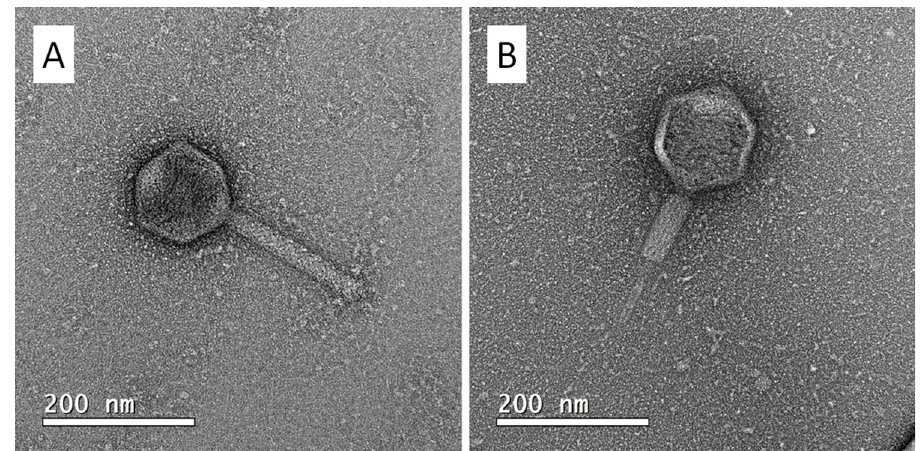
Fig 1. Transmission electron micrograph (TEM) of vB_XciM_LucasX particles. A phage lysate (10 9 PFU/mL) in NB were placed on a negatively-charged copper grid and stained with 2% uranyl acetate. The grid was analyzed in a JEM-2100 (JEOL) at 200kV. Phage particles can be seen with their tail extended (A) and contracted (B), which is typical of phages of the Myoviridae family.